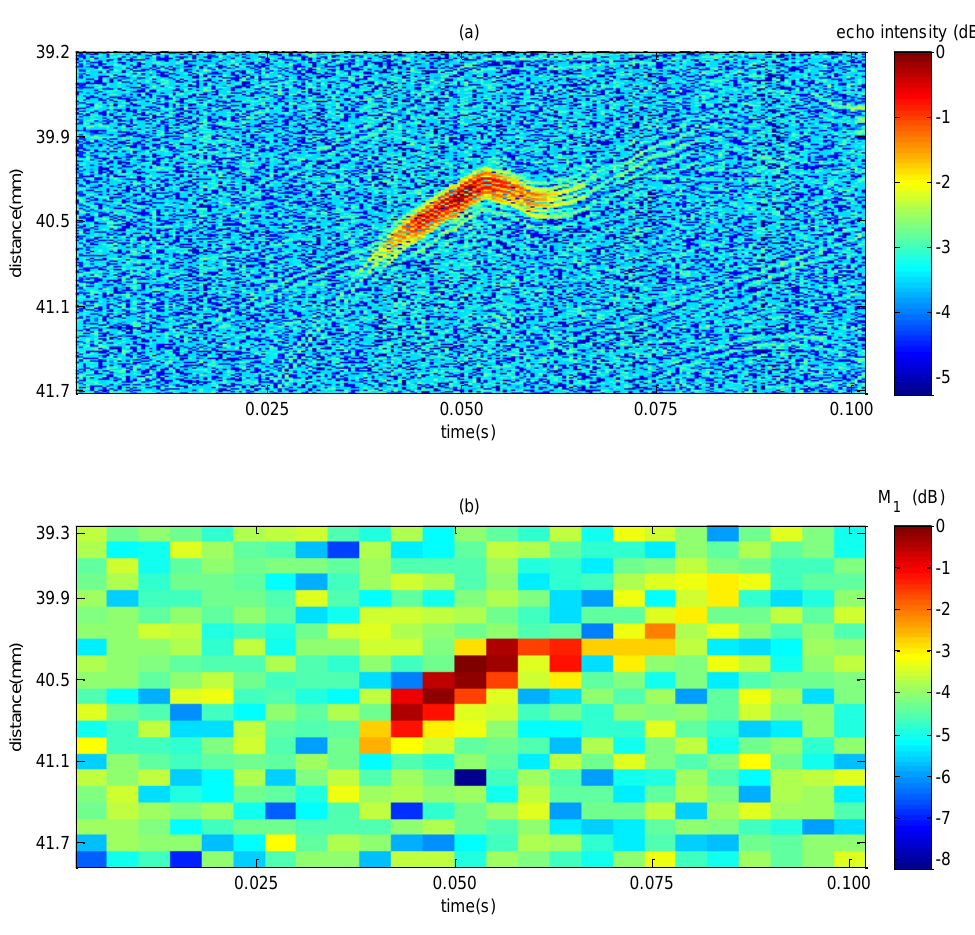
Figure 9. Comparison of bubble disturbance in a map built with M intensity. In ( a ) echo intensity spatiotemporal map showing disturbance caused by a bubble pass. ( b ) M map corresponding to the same time-distance range described in 1